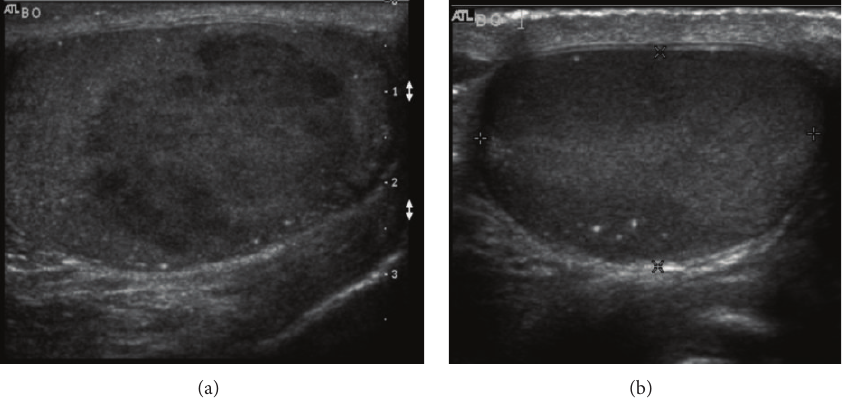
Figure 1: Scrotal ultrasound. (a) (R), (b)